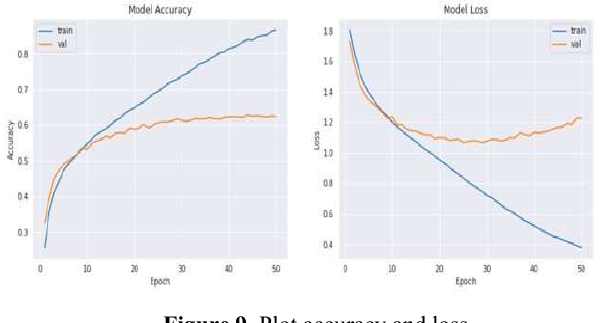
Figure 9 . Plot accuracy and loss